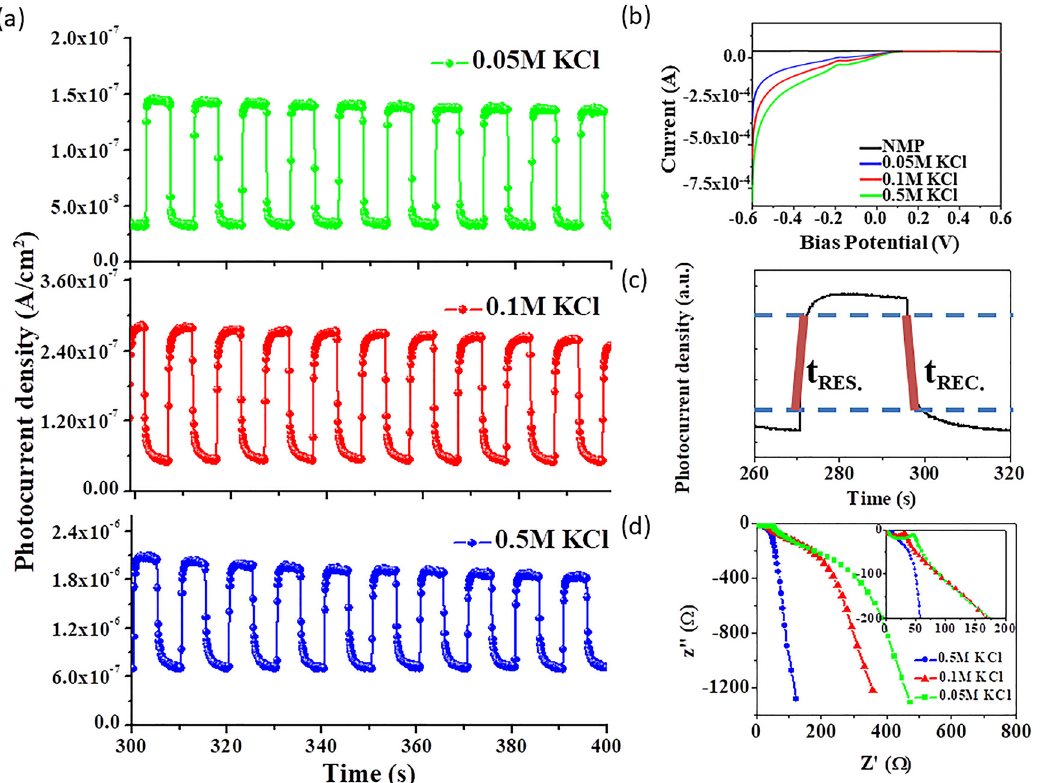
Figure 6: (a) Photocurrent measurements in various KCl concentration under dark and light environments. (b) Current versus bias potential under different KCl concentration and NMP solution. (c) Normalized photocurrent density under different time associates with exponential equation and the time constants for the response and recovery. (d) The impedance spectroscopic graphdiyne in various KCl